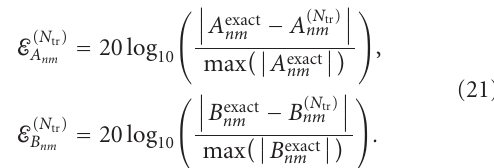
and (b) plot is E (38) . A nm B nm